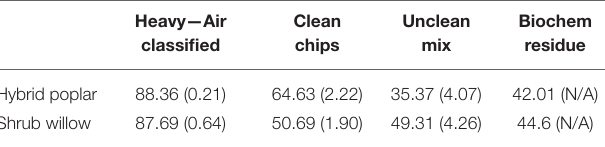
TABLE 1 | Mass fractions on a dry basis for hybrid poplar and shrub willow fractionation